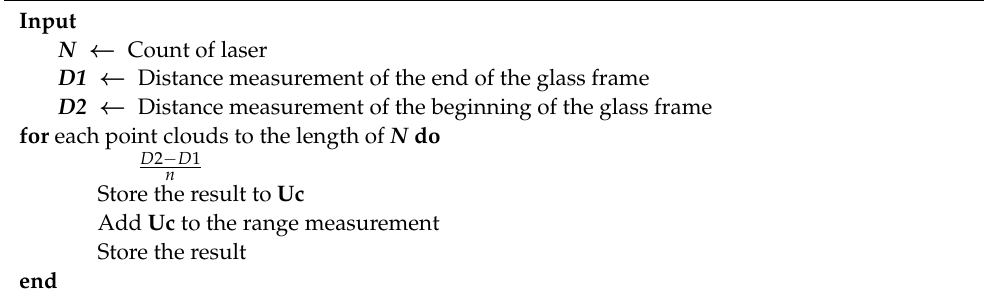
Algorithm 3 Update distance (Similar method used for updating cartesian coordinates) Input